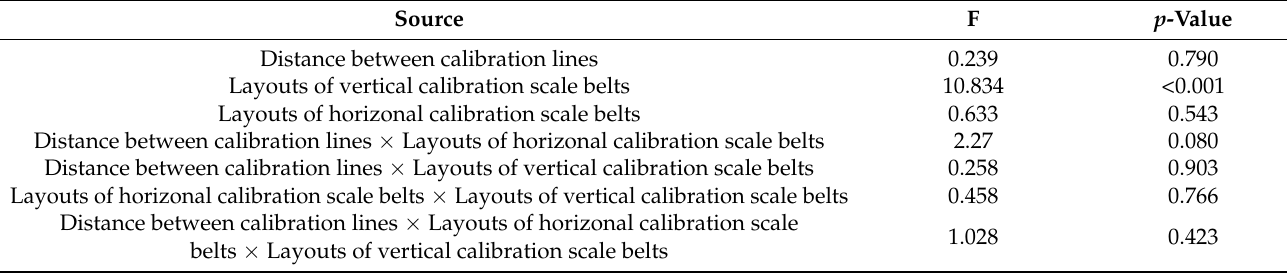
Table 2. ANOVA for task completion time.